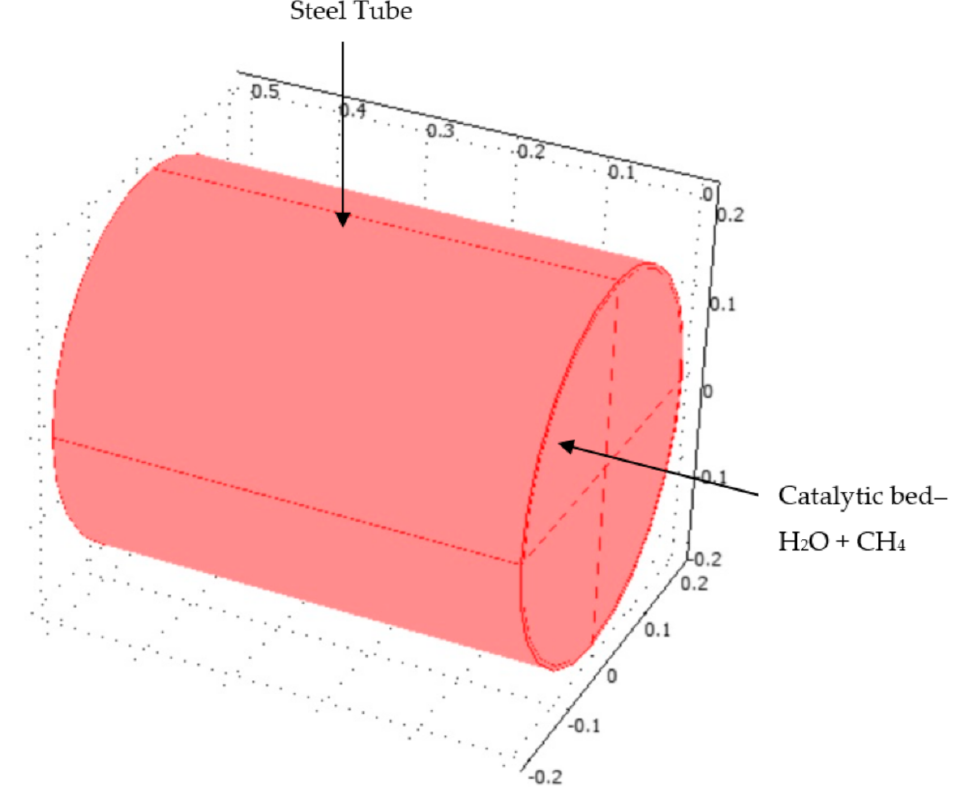
Figure 9. 3D plot of the